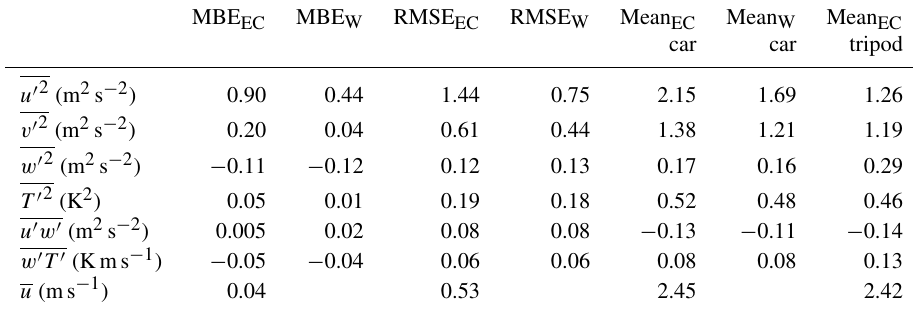
Table 3. Statistics calculated over all measurement passes (i.e., on both tracks on 20 and 22 August). Subscript EC denotes a statistical variance or a covariance calculated using eddy covariance. A subscript W denotes a variance or covariance calculated using wavelet analysis. MBE EC MBE W RMSE EC